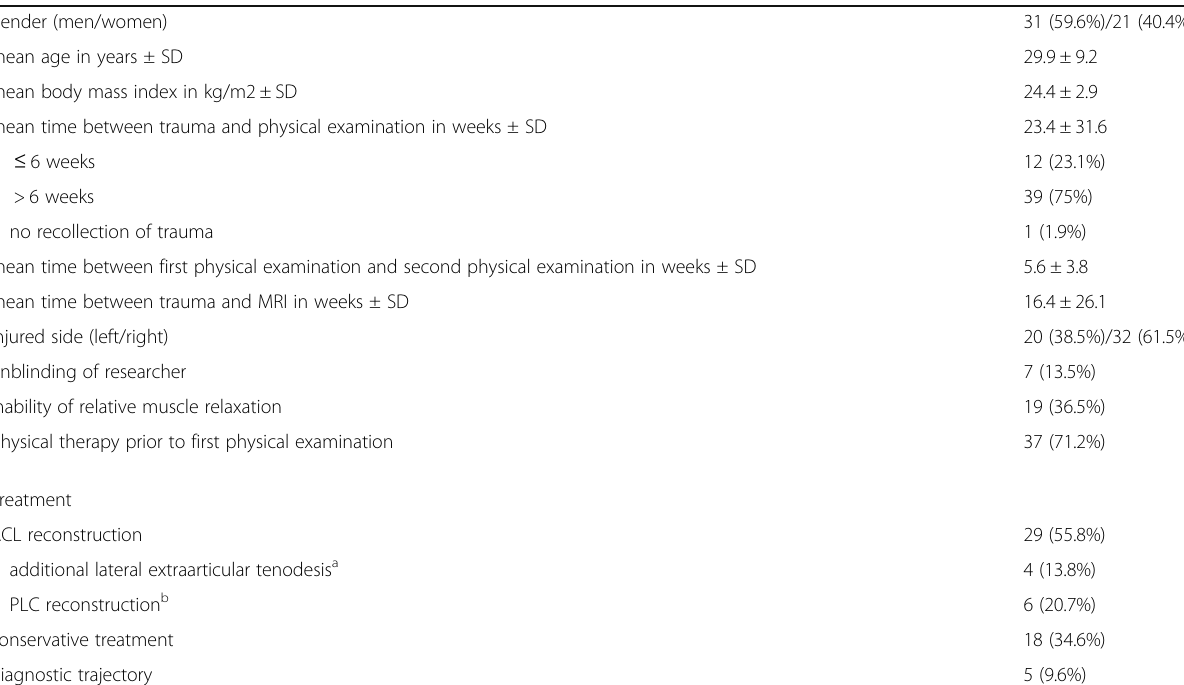
Table 1 Patient characteristics of 52